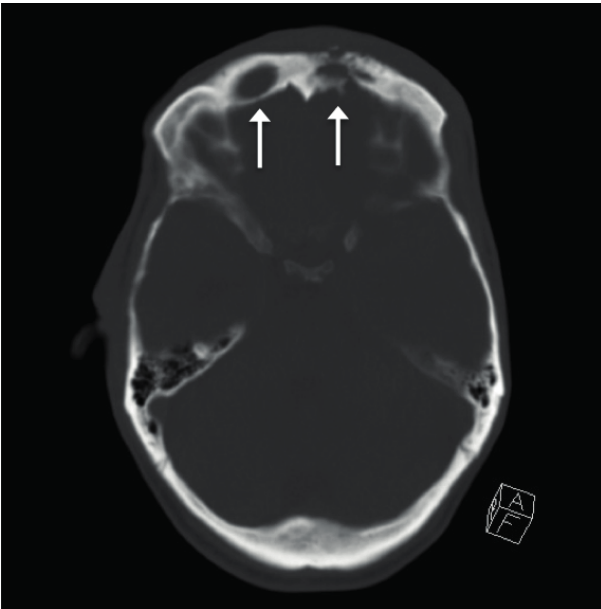
Figure 3. Axial CT scan (at first visit) showing osseous destruction of the posterior wall of the right frontal sinus and osseous destruction of both the anterior and posterior wall of the left frontal sinus (arrows).